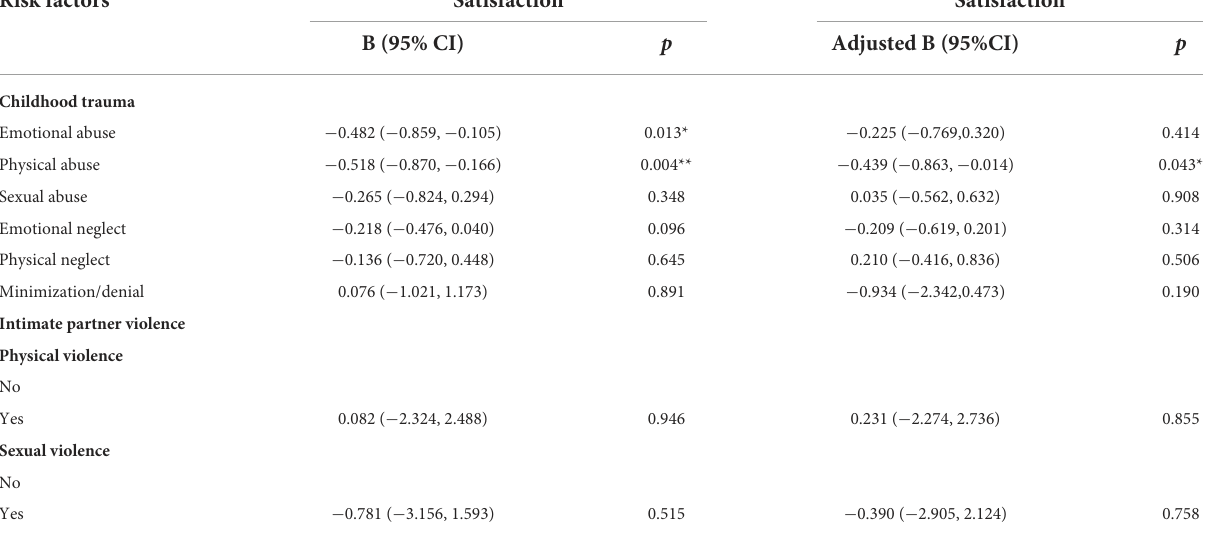
TABLE 6 Simple and multiple linear regression analyses on relationship between childhood trauma domains and intimate partner violence with parental satisfaction. Risk